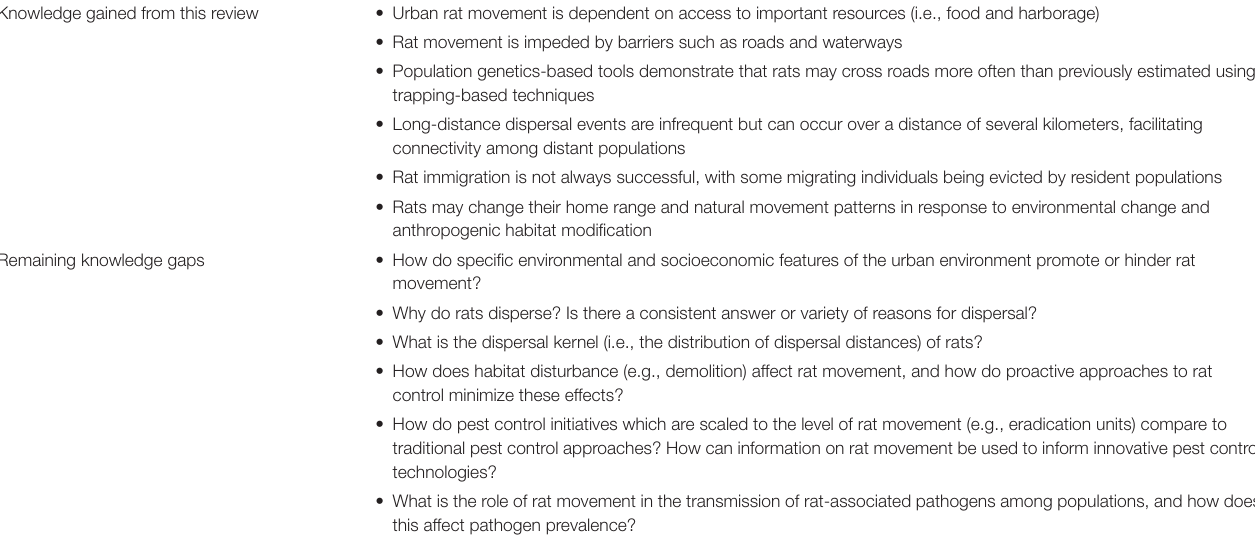
TABLE 1 | Conclusions from a review of the published literature describing Norway and black rat ( Rattus norvegicus and Rattus rattus ) movement in urban centers. Knowledge gained from this